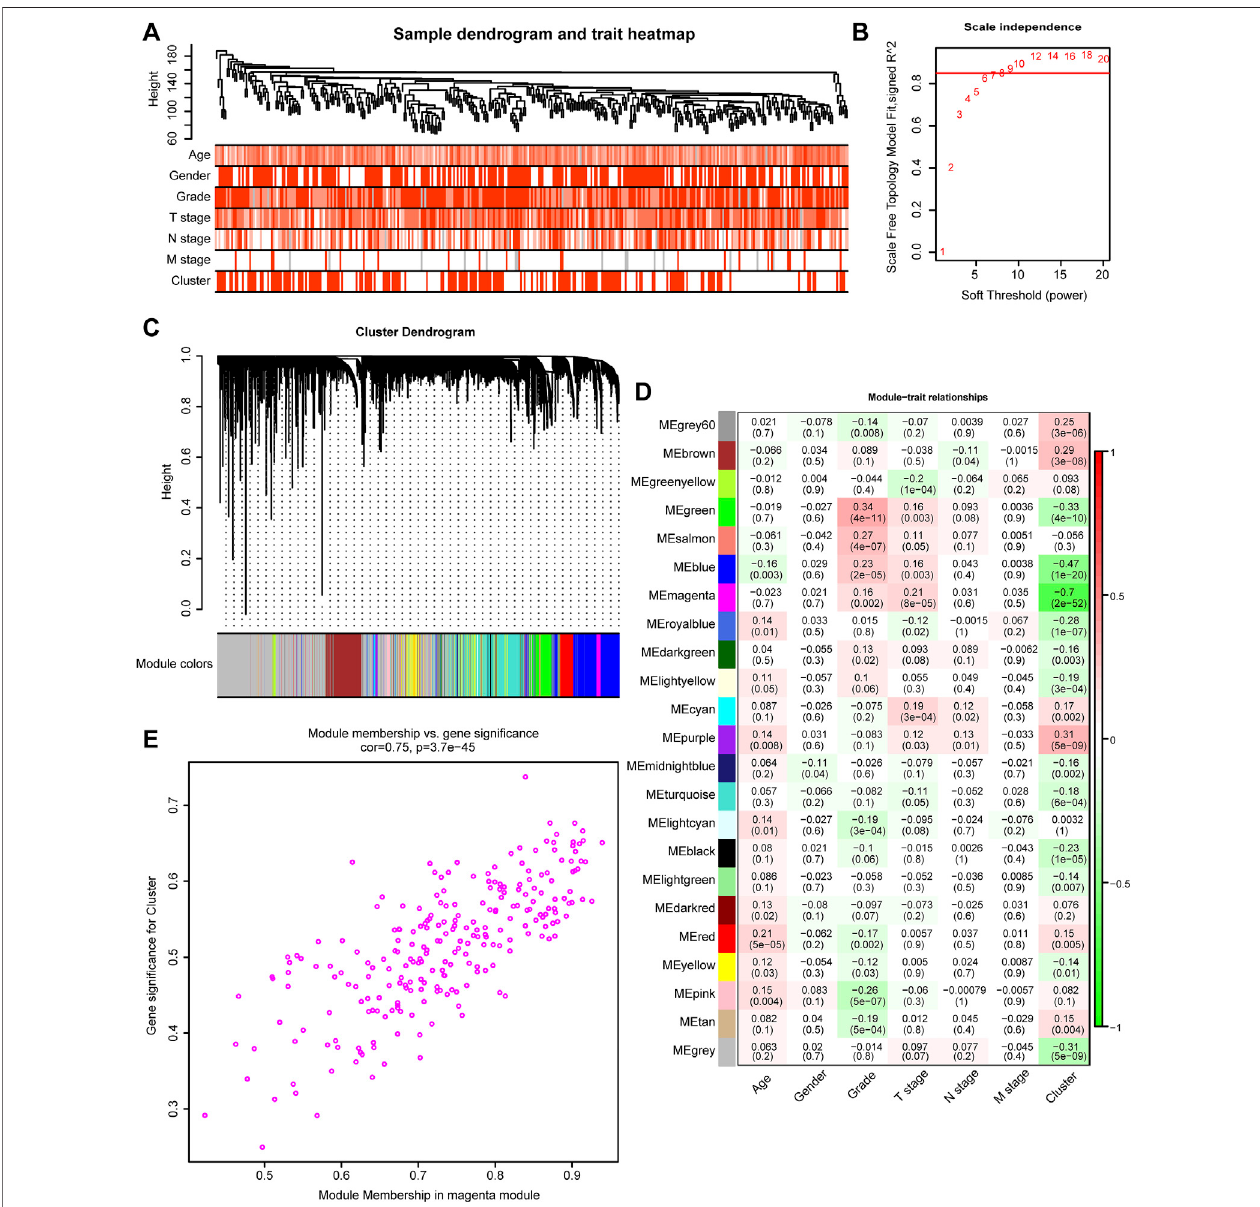
FIGURE2| TGF β -related modules detected byWGCNA. (A) Clusteringdendrogramand heatmaps ofclinicalcharacteristics (age, sex,tumor stage, tumor grade, andcluster)basedon350samplesintheTCGA-STADdataset. (B) Scaleindependenceanalysisbythescale-freetopologymodelofdifferentsoft-thresholdpowers. (C) Cluster dendrogram of differentially expressed genes based on the topological overlap. (D) Heatmap of the correlation between various gene modules and clinical characteristics (age, sex, tumor stage, tumor grade, and cluster). Red and green represent a positive and negative correlations, respectively. (E) The Scatter plot shows the correlation between gene memberships in the magenta